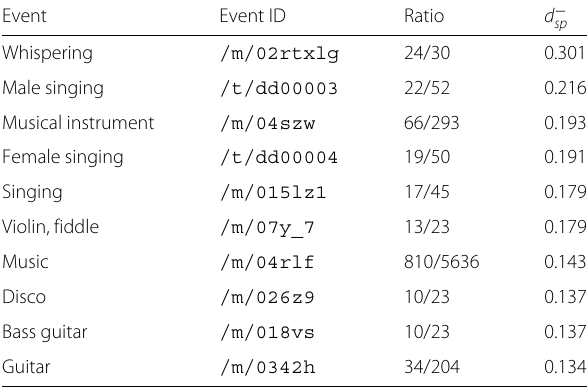
Table 10 Top 10 negative distractor events for speech (event labels related to false negative decisions of the network about the “speech” class)